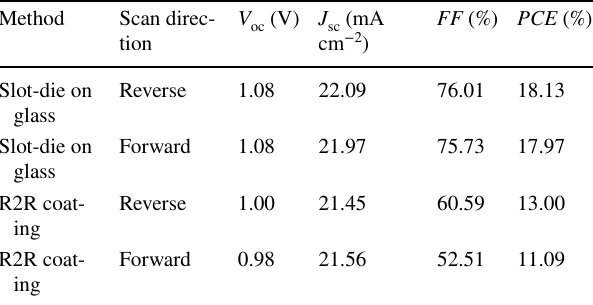
Table 2 The performance parameters of the champion PSCs pre- pared by slot-die coating were measured under reverse and forward scan directions